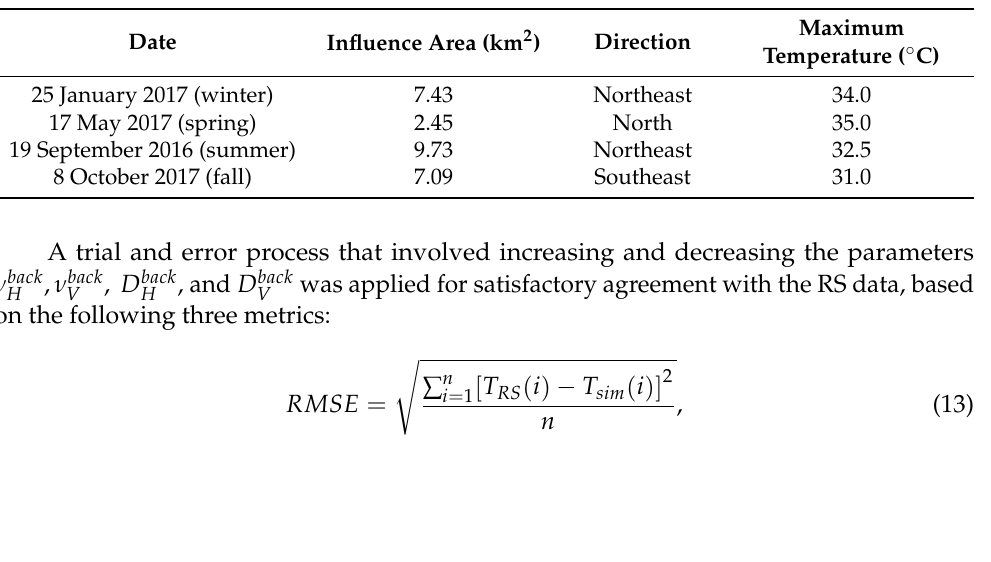
Figure 8. Isotherms obtained from RS: ( a ) winter, 25 January 2017; ( b ) spring, 17 May 2017; ( c ) summer, 19 September 2016; ( d ) fall, 8 October 2017. Table 4. Characteristics of the thermal plumes obtained from RS